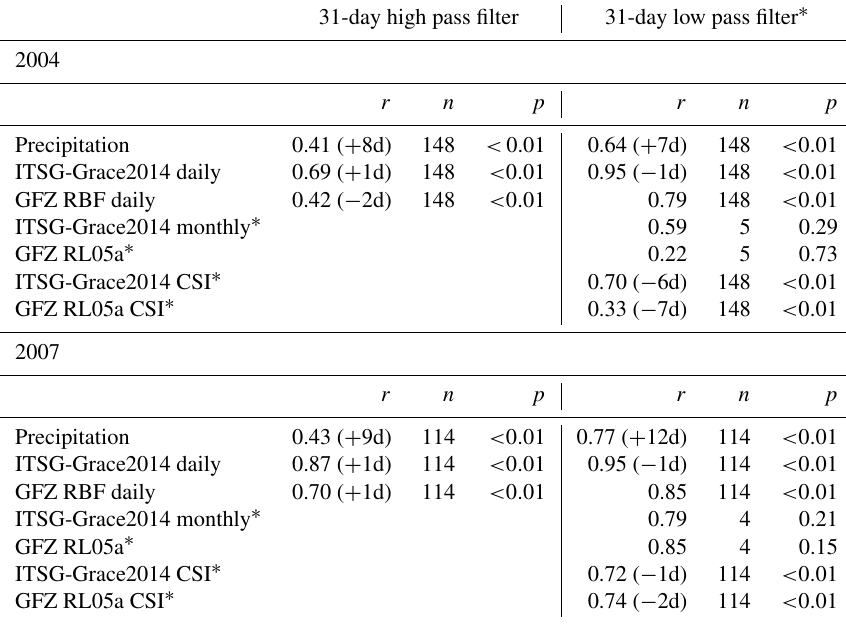
Table 1. Correlation of daily and monthly TWSAs and daily precipitation with river runoff anomalies in(to) the GBD for the years of major flooding in 2004 and 2007. A high-pass filter (HPF) with a 31-day window separates daily data. The low-pass filter (LPF) component of the filter, the monthly data and a series of cubic spline interpolations (CSIs) fitted to the monthly data have the mean seasonal cycle removed. Pearson’s linear correlation coefficient ( r ), sample size ( n ) and a ( p ) value for testing the hypothesis of no correlation are indicated. Time lag, if applicable, is indicated in days in brackets (a positive time lag denotes a delayed river runoff